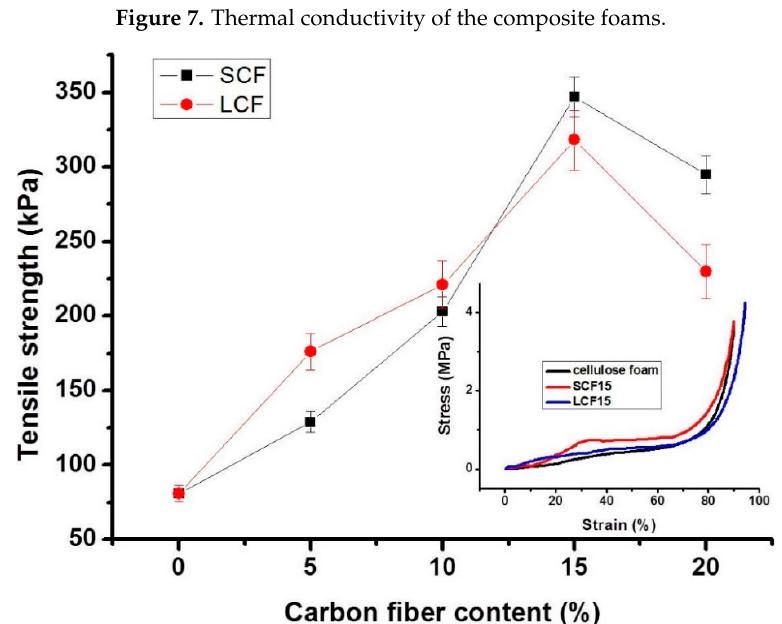
Figure 8. Mechanical properties of the cellulose composite foams as a function of carbon fiber content. Insert figure—compressive strength of the foams as a function of strain.